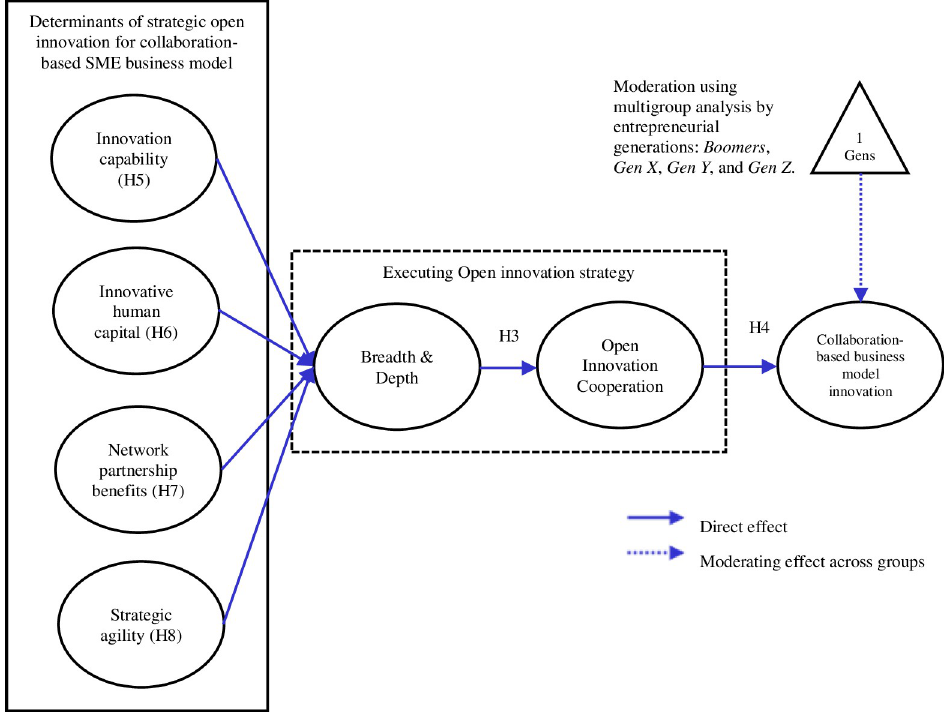
Fig 1. Figure generated by authors,